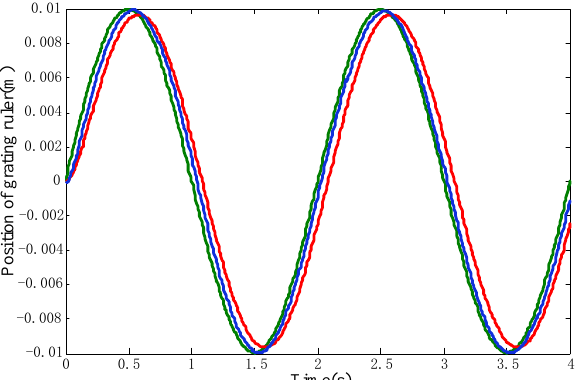
Table 3. Performance of the proposed method and PID controller.